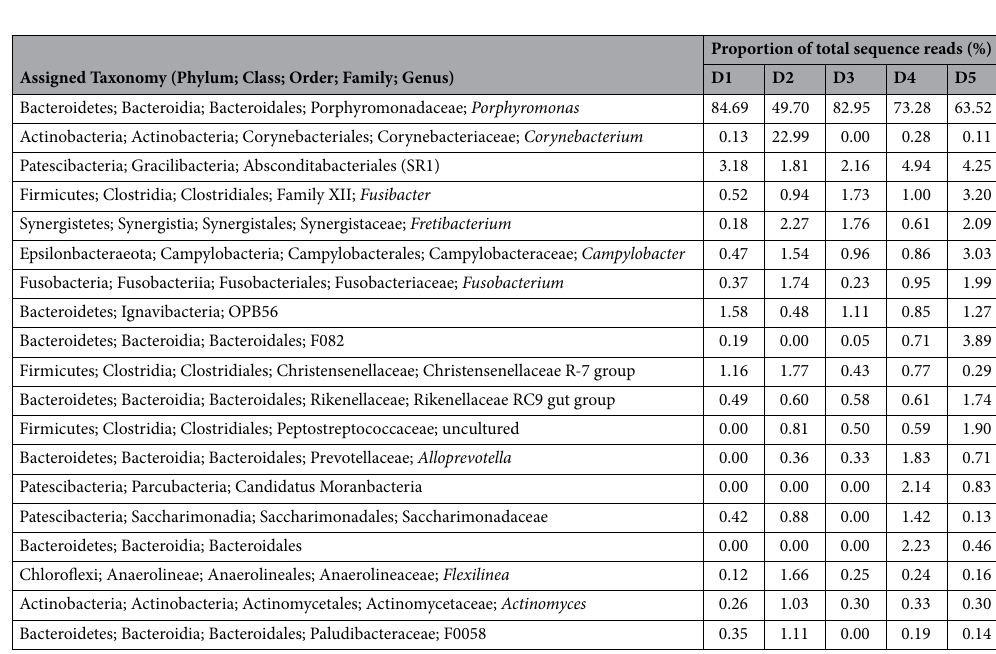
Figure 2. Composition of total bacterial community of canine dental biofilms. ( a ) Composition of total bacterial community at the phylum level, ( b ) families of phylum Bacteroidetes, ( c ) families of phylum Actinobacteria.